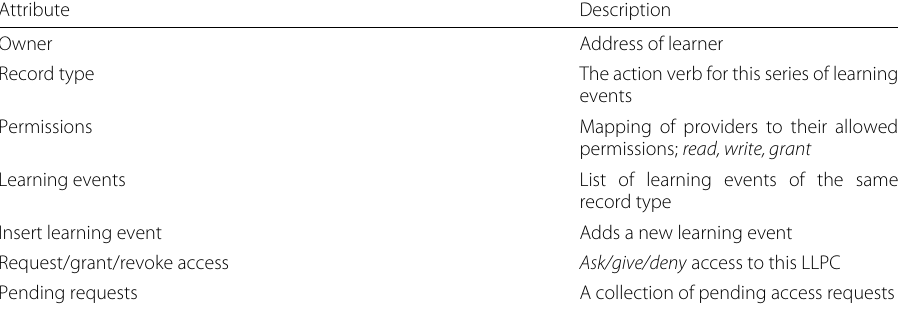
Table 5 Learner-learning provider contract (LLPC)